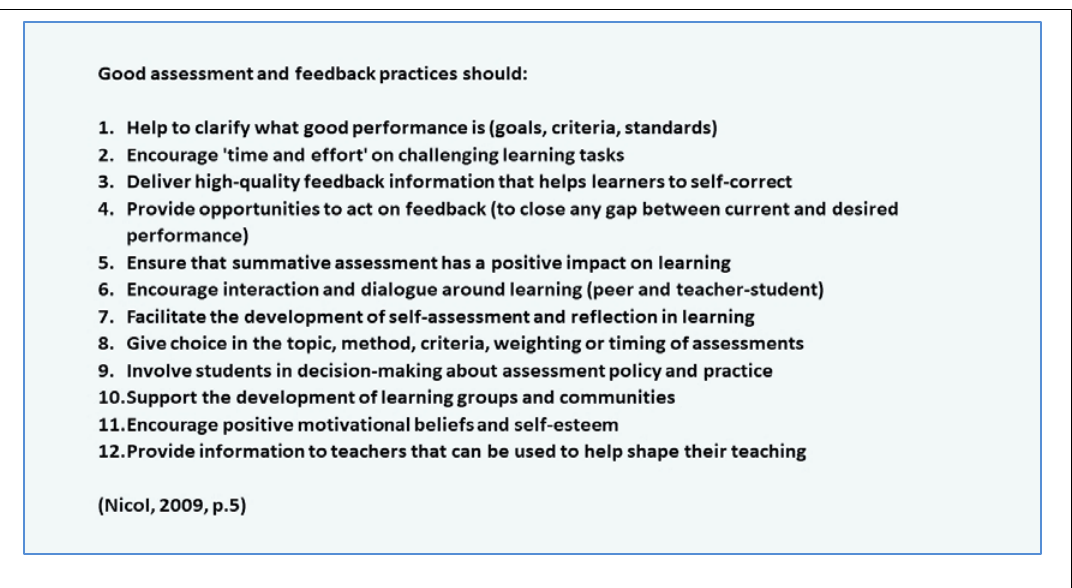
Figure 1: Nicol's 12 principles of first-year